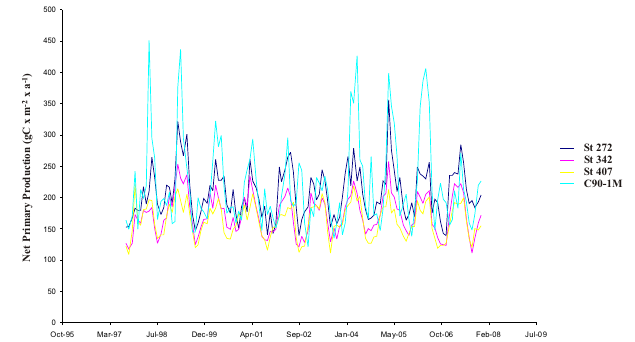
Fig. 2. Net Primary Production data, expressed in milligrams of carbon per square meter per day (mgC × m − 2 × d − 1 ) , calculated at core locations with an approximate resolution of about 9 × 9 square kilometers, between September 1997 and April 2007 (http://web.